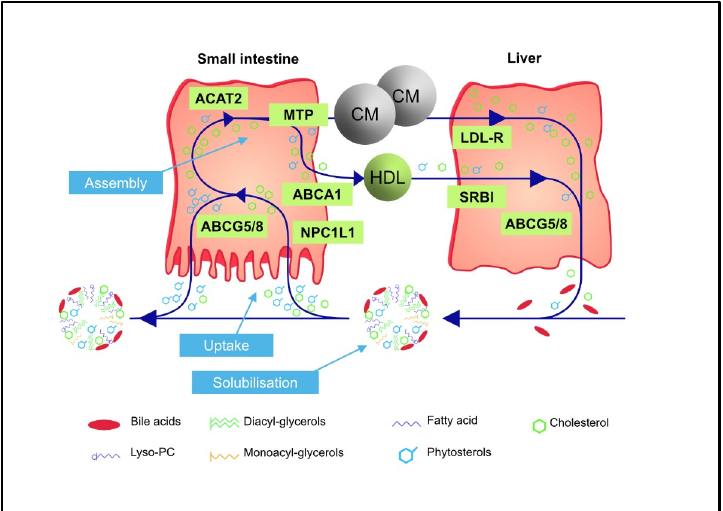
Figure 1. Flux and homeostasis of sterols (cholesterol and non-cholesterol sterols) with a focus on intestinal absorption and biliary secretion (adopted and modified from [26]. ABCA1, ATP binding cassette transporter A1; ABCG5/8, ATP binding cassette co-transporters G5 and G8; ACAT2, ace- tylcoenzyme-A cholesterol acyl transferase 2; CM, chylomicron; HDL, high-density lipoprotein; LDL-R, low-density lipoprotein receptor; MTP, microsomal triglyceride transfer protein; NPC1L1, Niemann Pick C1-like 1 protein; SRBI, scavenger receptor class B type 1. 3. Phytosterolemia—An Inherited Disorder of Sterol Transport Clarification of the pathophysiology of phytosterolemia has improved our under- standing of phytosterol metabolism [2]. Phytosterolemia is caused by homozygous or compound heterozygous defects in the genes ABCG5/sterolin-1 and ABCG8/sterolin-2 on chromosome 2p21 [27–32]. These genes encode the obligate heterodimeric ABC transport- ers, ABCG5 and ABCG8, with the result that a defect in one of the two monomers may cause a malfunction of the entire heterodimer. The ABCG5/G8 transporter pumps sterols, such as cholesterol, but preferably PSs, from the apical surface of the enterocytes back into the small intestine, as well as cholesterol and PSs from hepatocytes into the bile ducts [5,33]. The excretion of PSs from the hepatocytes into the bile canaliculi is necessary since, in mammalians, most PSs cannot be converted into bile acids and are subsequently ex- creted [34,35]. Phytosterolemia has been considered a rare inherited disease. Worldwide, only some 100 phytosterolemia cases have been described limiting possible correlations to clinical manifestations. However, based on recent advances in genetics, the prevalence of individ- uals with detrimental mutations in ABCG5/G8 genes may be more than 1 in 200,000 indi- viduals [1]. Phytosterolemia may also be underdiagnosed because clinically it is difficult to distinguish clinically from familial hypercholesterolemia (FH). 3.1. Plasma Sterol Concentrations and Cardiovascular Disease in Phytosterolemia Characteristic symptoms of phytosterolemia, including severe hypercholesterolemia, xanthomas, aortic stenosis, as well as fatal and non-fatal cardiac events, have been re- ported predominantly in infants/children up to the age of adolescence, whereas these complications are apparently not as frequent with increasing age. In adults, mostly low to